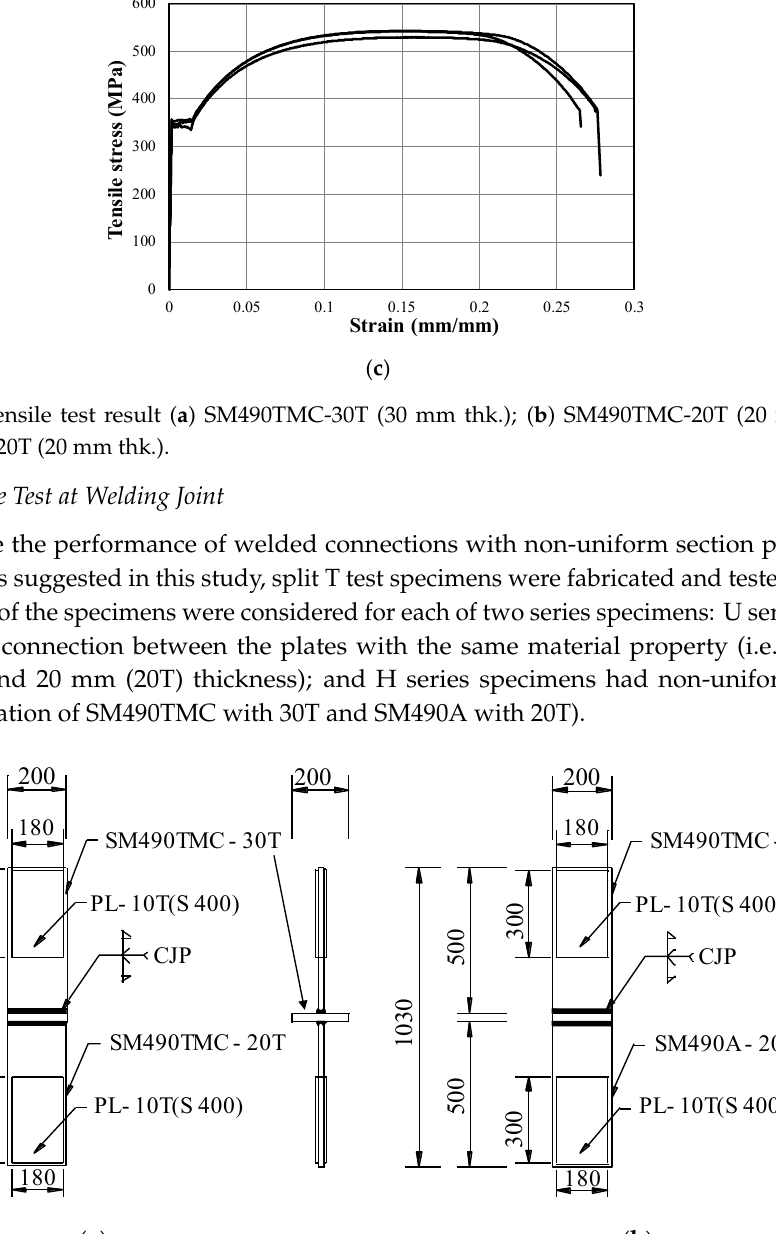
Figure 5. Specimens for direct tensile test at welding joint.